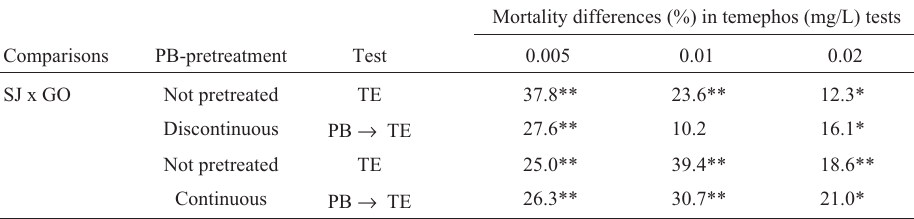
Table2 -ComparisonbetweenthepercentagemortalityofSãoJosédoRioPreto(SJ)andGoiânia(GO) A.aegypti exposedtotheorganophosphatetemephos(TE)intestswith L4 larvae which had not been pretreated with phenobarbital (PB) and L4 larvae submitted to discontinuous and continuous pretreatments with PB. Mortality differences (%) in temephos (mg/L) tests